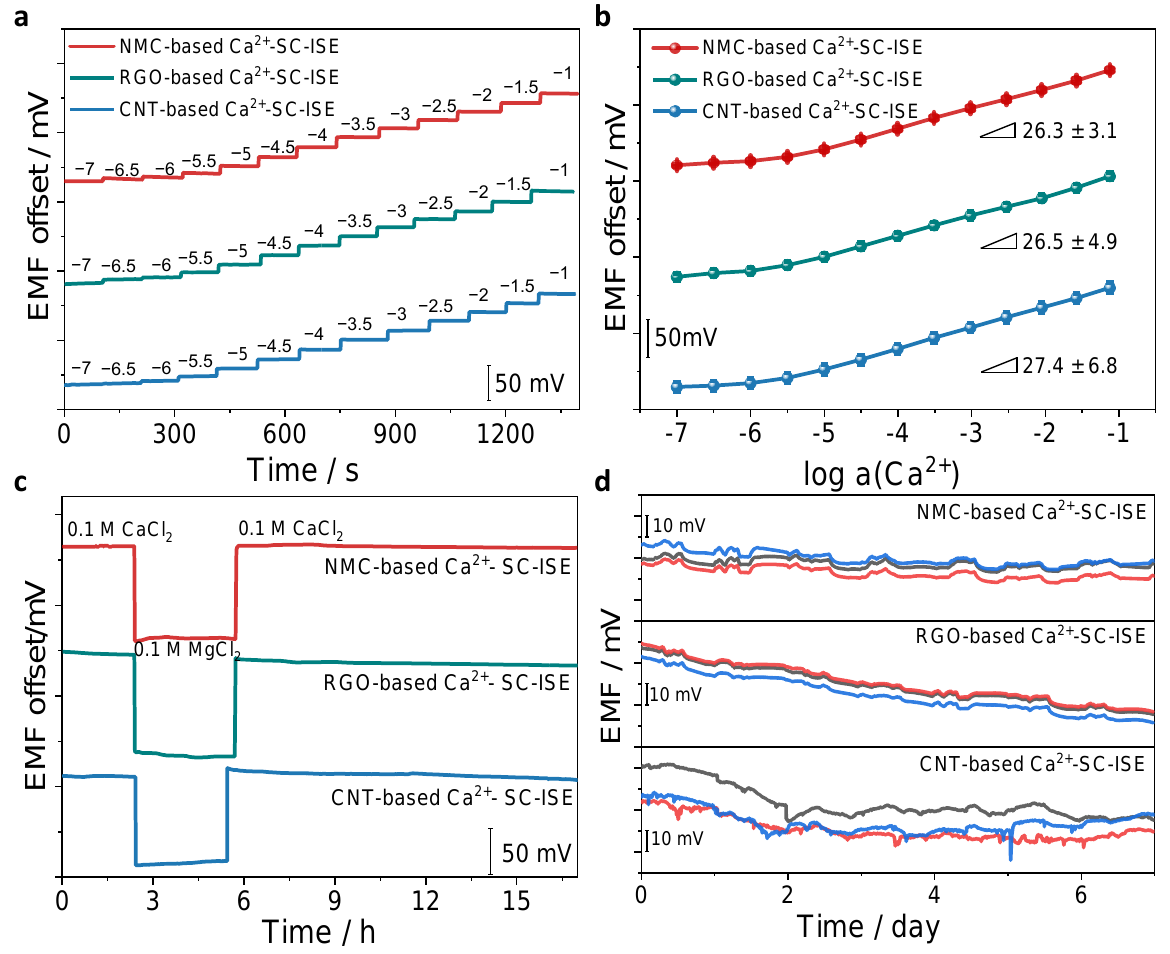
Figure 4. Performance comparison of NMC-, RGO- and CNT-based Ca 2+ -SC-ISEs. ( a ) Potential response measurements through increasing the concentration of Ca 2+ in the solution. ( b ) Linear calibration curves of Ca 2+ responses. ( c ) Water-layer tests. ( d ) Long-term stability monitoring for 7 days. The potential drifts were calculated according to the potential differences between the maximal and minimal potentials during the whole test time. The error bars reflect the results of three individual measurements.